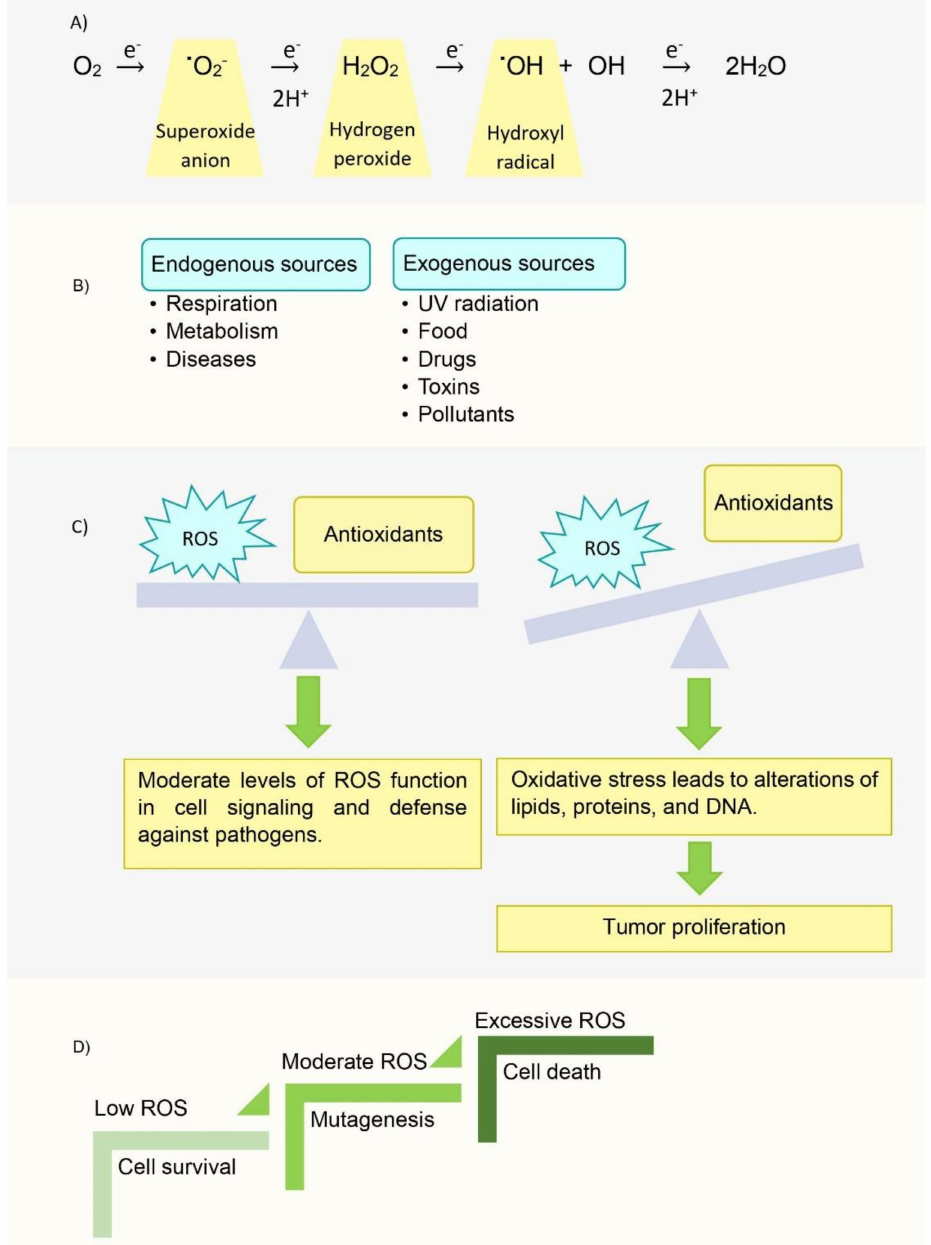
Figure 8. Reactive Oxygen Species. ( A ) Complete reduction of oxygen via ROS formation. ( B ) Sources of ROS production. ( C ) Balance of ROS and antioxidants in normal cells. ( D ) Levels of ROS in cancerous